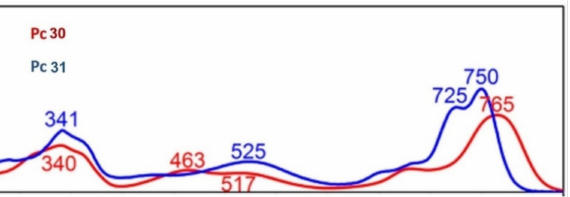
Figure 13. Comparison in the electronic absorption spectra between Pcs 30 and 31 , recorded in CHCl 3 . Adapted with permission from ref [141]. Copyright 2016 American Chemical